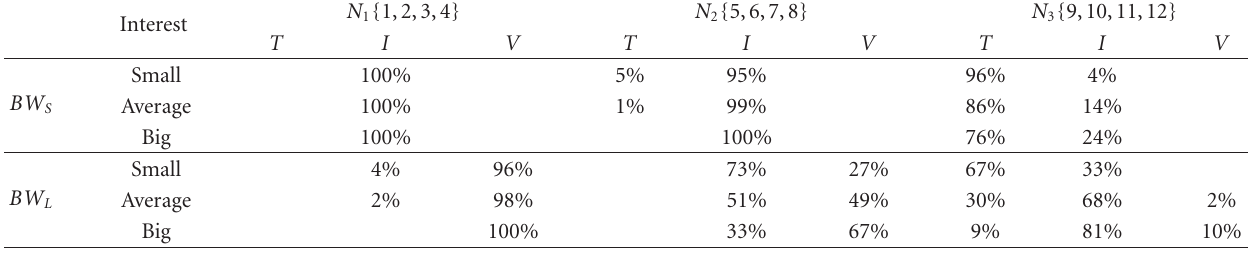
Table 4: Actions’ distribution for the POMDP solution policy.